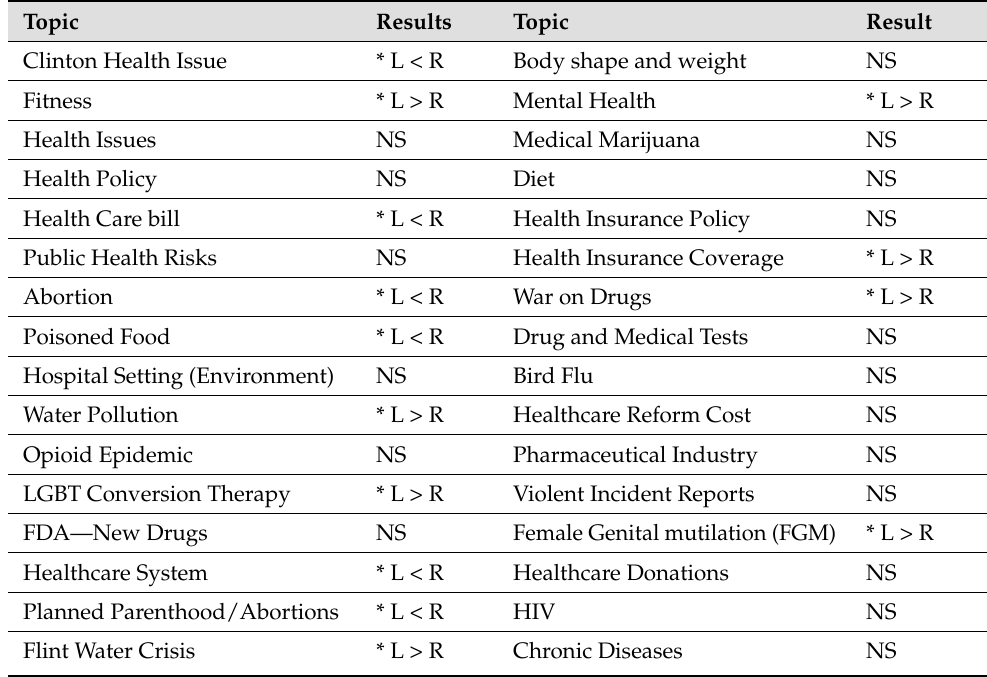
Table 2. Comparison of left (L) and right (R) Trolls based on the mean of Health-related Topics (NS: p -value > 0.004; * p -value ≤